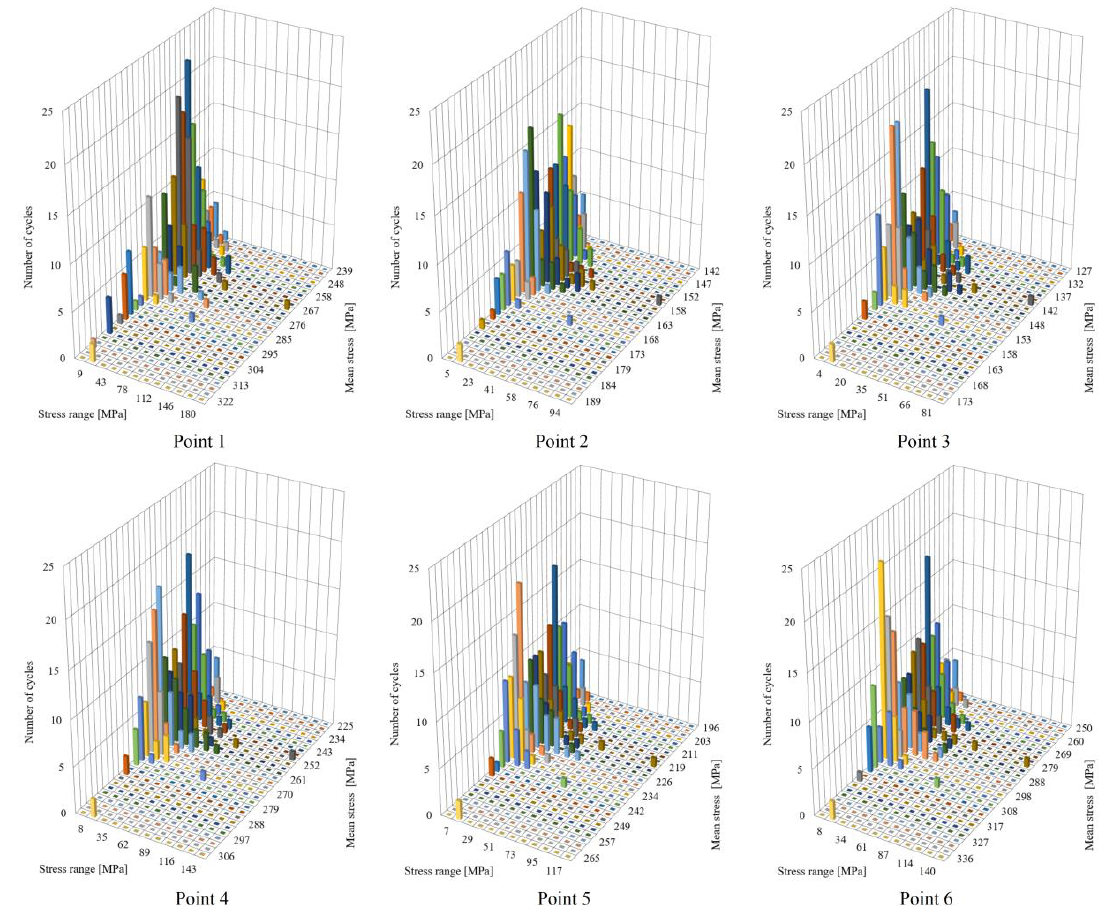
Figure 14. Rainflow cycle counting histograms of reversed stress cycles at concentration points.